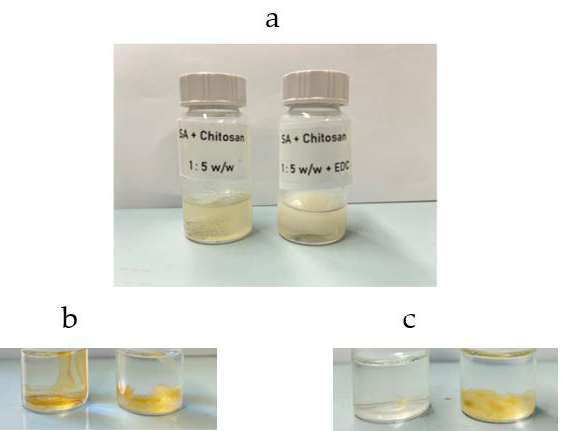
Figure A4. ( a ) Chitosan solution and formation of crosslinked chitosan; chitosan, and crosslinked chitosan membrane in water after ( b ) 7 days and ( c ) 30 days.